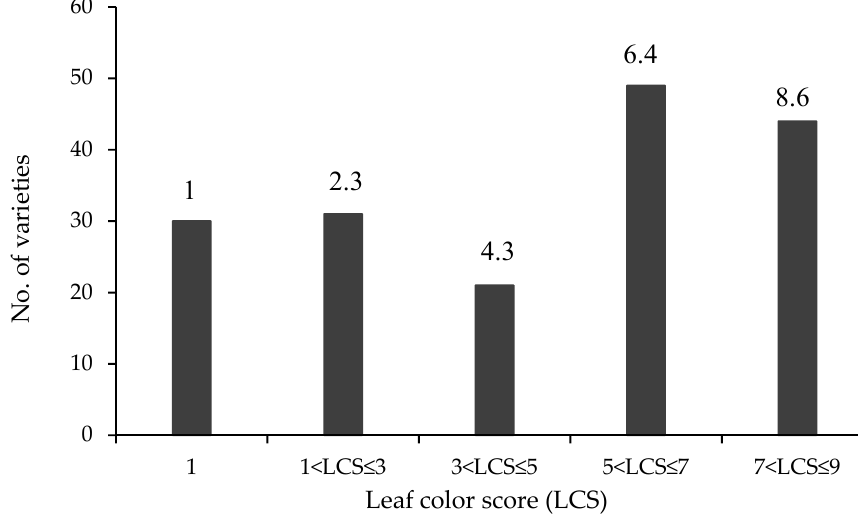
Figure 5. Frequency distribution of leaf color score of varieties under the cold stress condition. Numbers in the top of each column indicate the average leaf color score in each group.